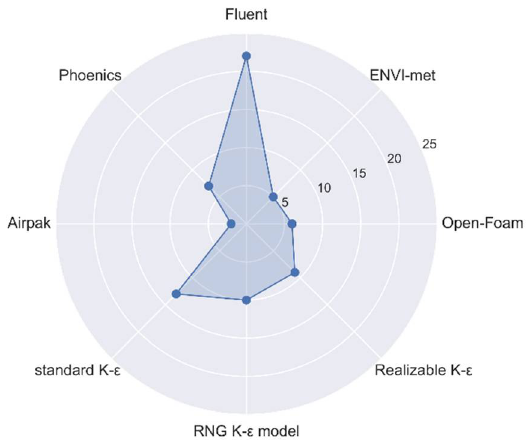
Figure 2. The distribution of the proportion of usage of different CFD simulation software packages and k - ε models.